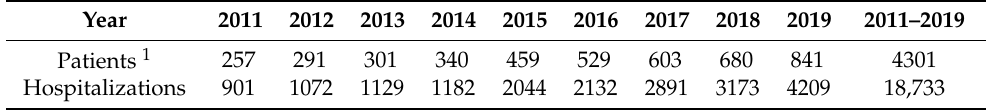
Table 3. Hospitalizations between